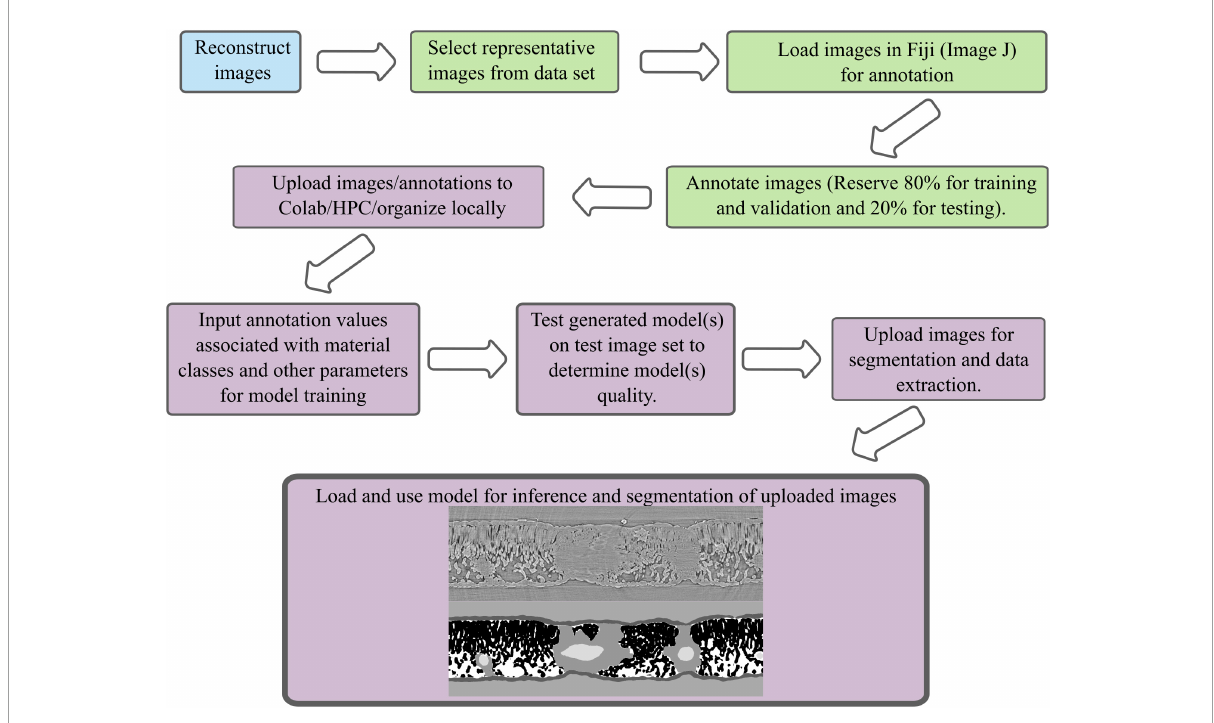
FIGURE1 A schematic of the segmentation workflow from image reconstruction, image annotation, model training, model use, and data extraction. Blue indicates a process that is done at the instrumentation site, green is a process done on local computers using a subset of the data in ImageJ or CVAT, purple indicates a process done in Google’s Colaboratory, on a high-performance computing cluster, or